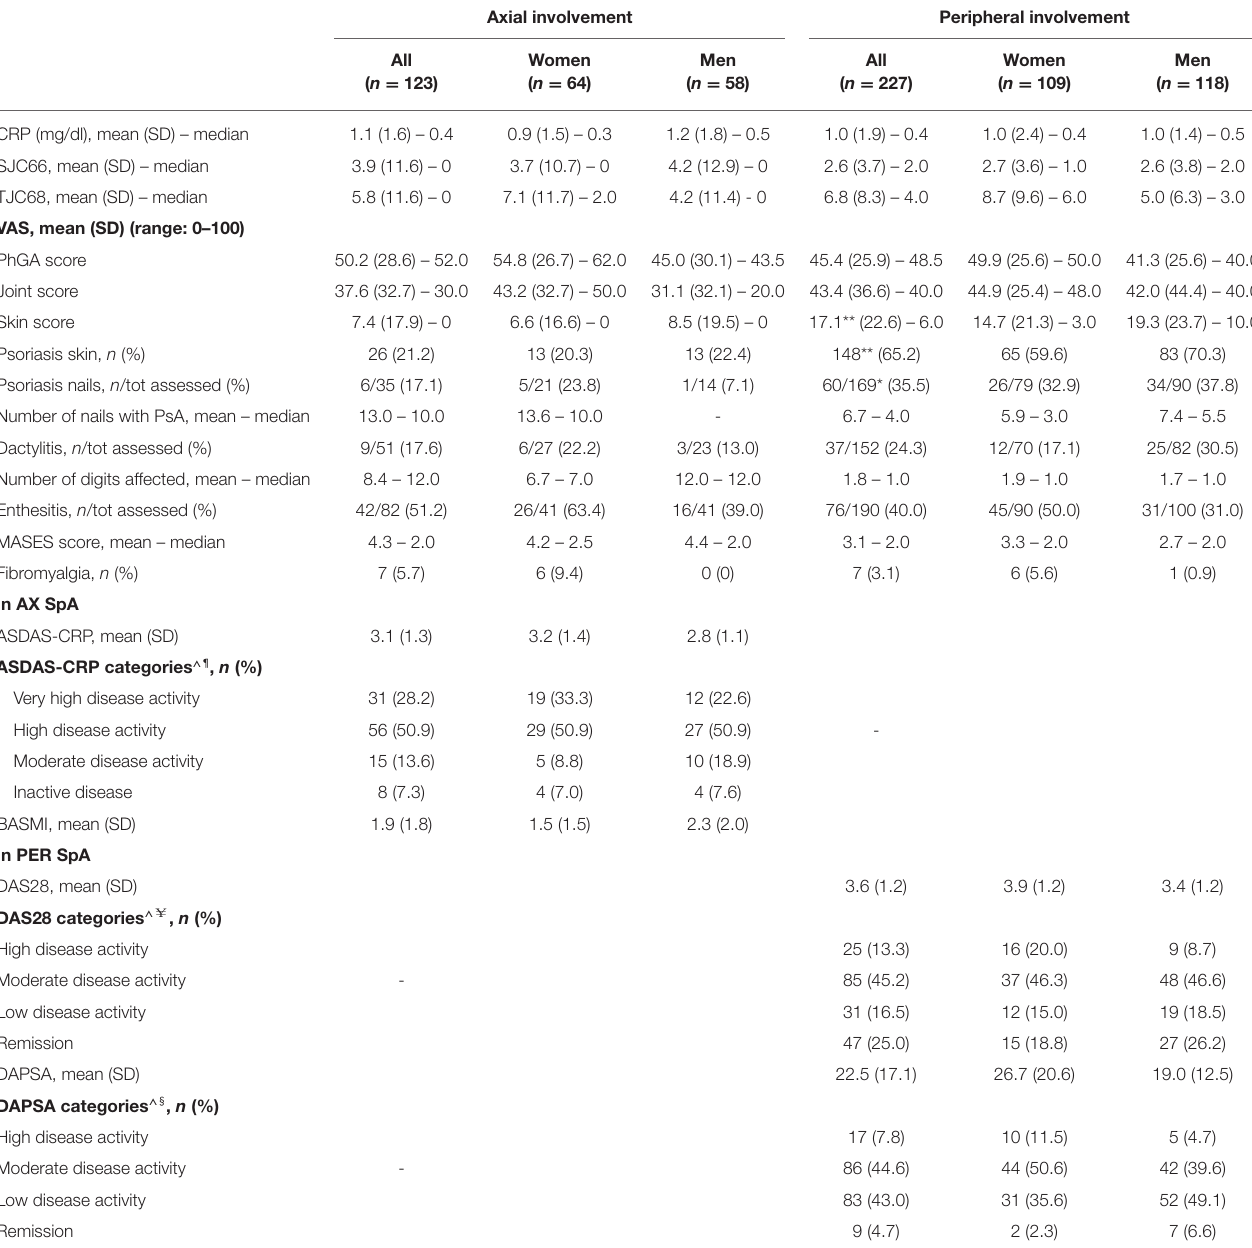
TABLE 2 | Baseline clinical assessment in 350 patients with SpA in the SIRENA study by involvement pattern and, in each subgroup, by gender ◦ . Axial